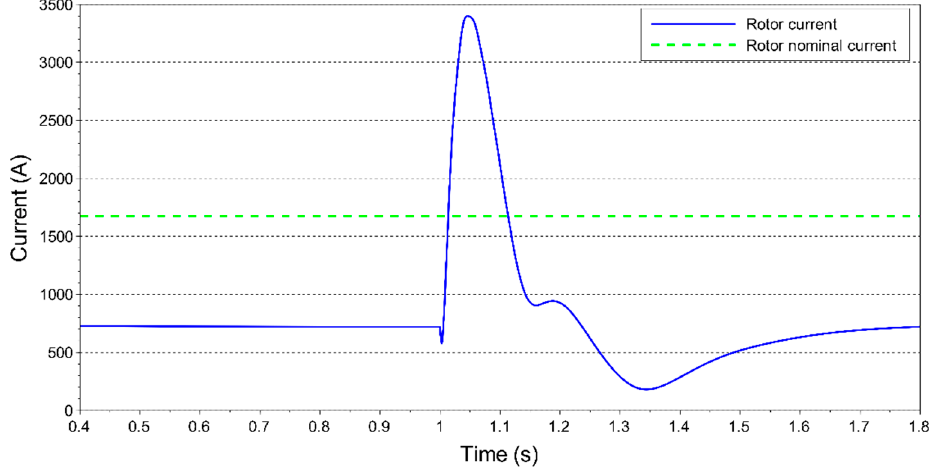
Figure 3. Rotor current after a reference step change compared to the rotor nominal current.